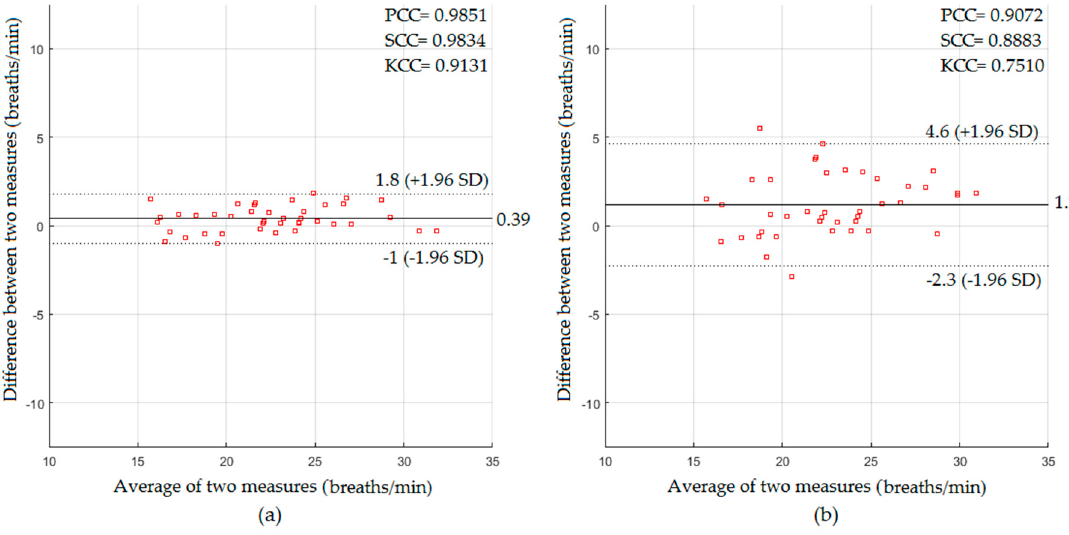
Figure 9. The statistics of RR measurements obtained in a dark environment for participants ( a ) without a blanket; ( b ) with a blanket. a blanket; ( b ) with a